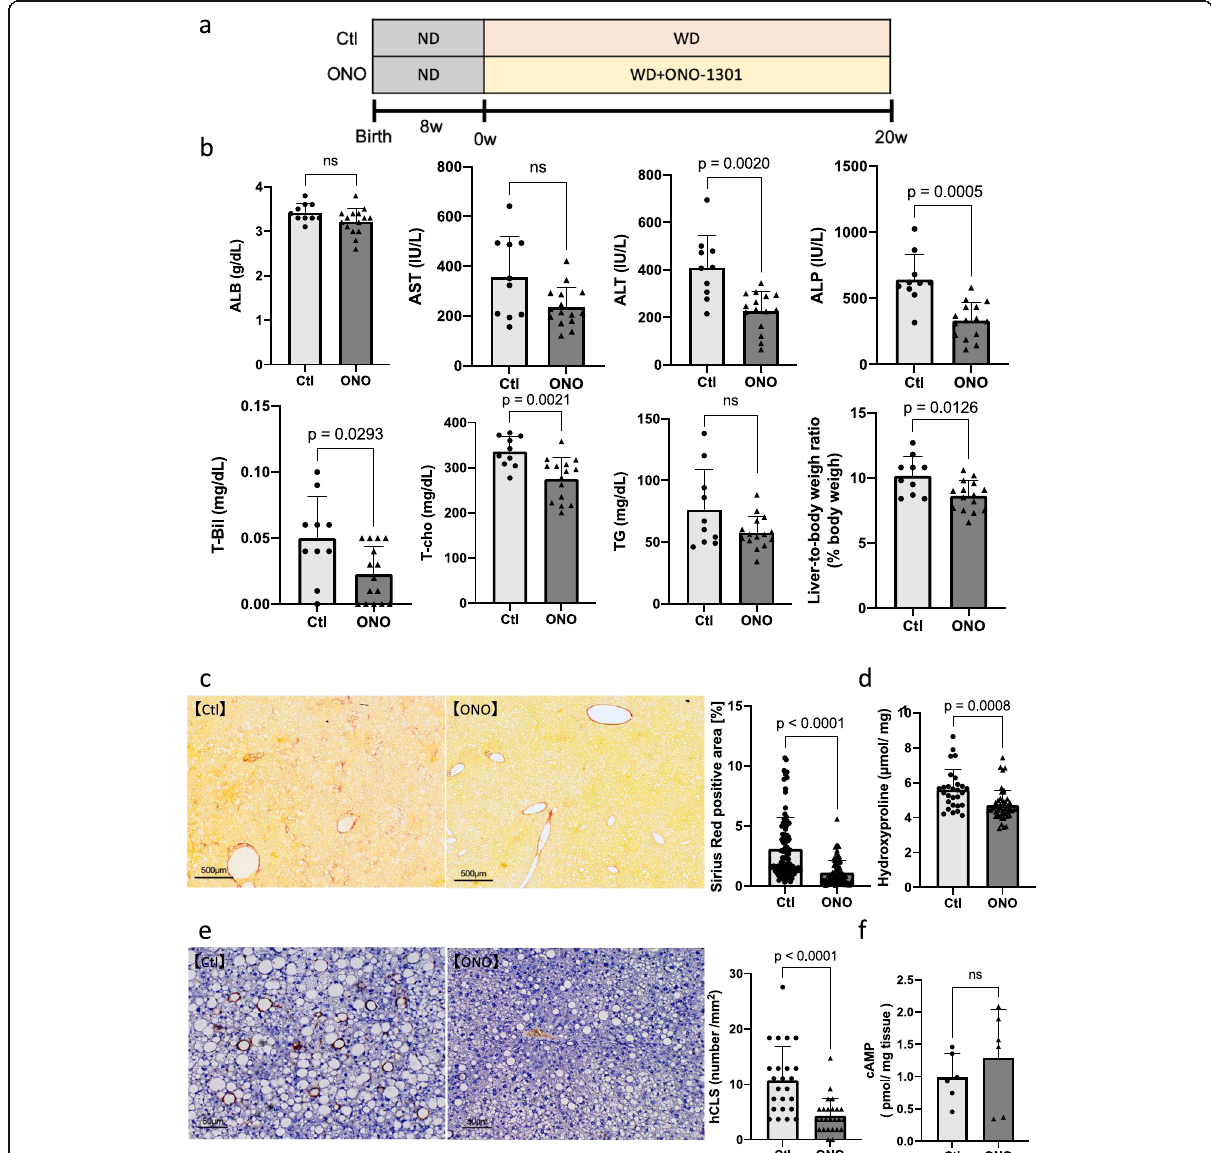
Fig. 1 Therapeutic effects of ONO-1301 (20 weeks of treatment) in the Mc4r -KO NASH model mice. Mc4r -KO mice were fed a Western diet from 8 weeks of age and followed up for an additional 20 weeks. A Schematic of the experiment. B Serum levels of albumin (ALB), aspartate transaminase (AST), alanine transaminase (ALT), alkaline phosphatase (ALP), total bilirubin (T-Bil), total cholesterol (T-cho), and triglyceride (TG). Liver-to-body weight ratios were analyzed. C Sirius Red staining of liver tissues. Scale bar = 500 μ m. The quantification of Sirius Red staining. D Quantification of hydroxyproline. E Immunohistochemistry of F4/80 and quantification of hepatic crown-like structures (hCLS). F The levels of cAMP in the liver tissues. Scale bar = 50 μ m. Total number of mice in each group: n = 6 – 10 in Ctl group, n = 6 – 15 in ONO group. Data are presented as mean ± standard deviation. ns: not